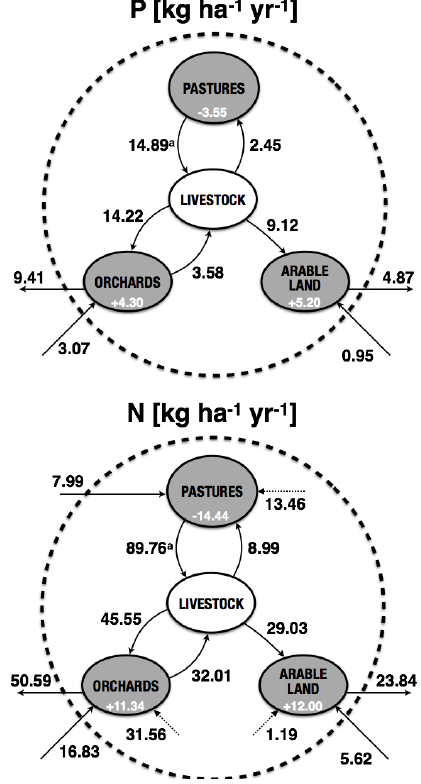
Figure 3. Long-term annual mean agricultural budgets in the Szamos/Some¸s catchment. a —half of yield is supported by natural nutrient supply of soils. An internal utilization of fodder crops and an export of other arable crops is assumed. Arrows pointing into the circle indicate the import of mineral fertilizers; dotted arrows denote N 2